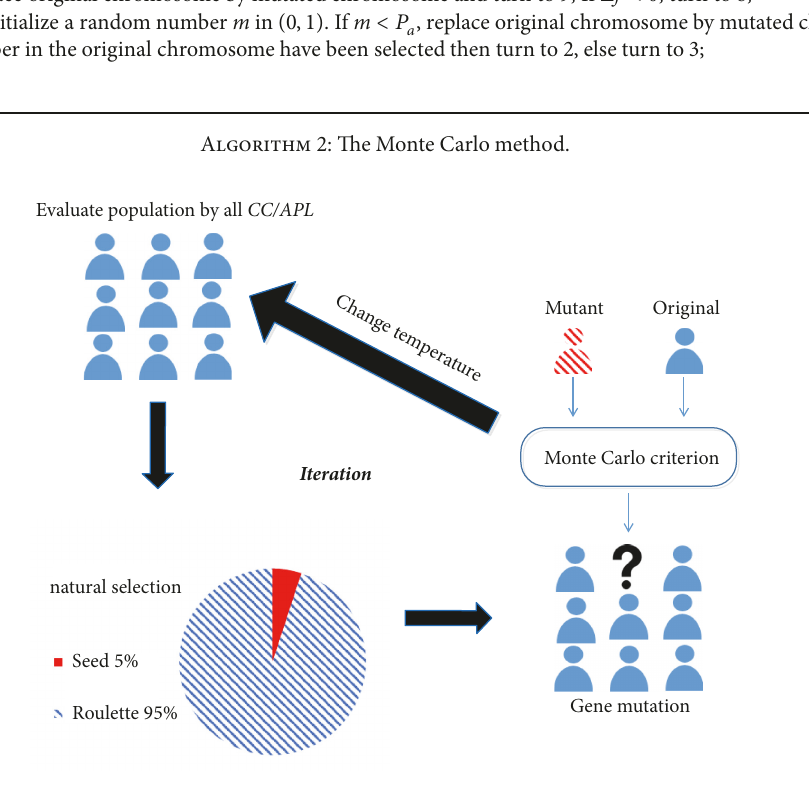
Figure 3: The iteration